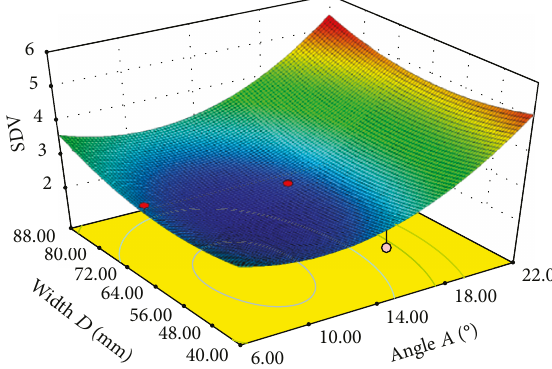
Figure 7: Response surface plots of the SDV as a function of outlet width D and angle A